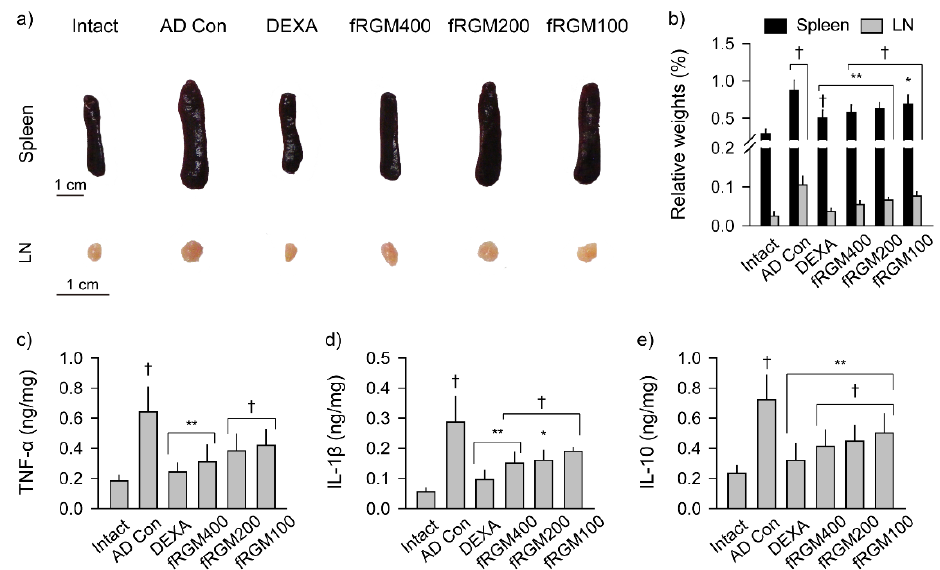
Figure 3. Effects on lymphoid organs and the production of inflammatory cytokines. ( a ) Representa- tive images of the spleen and lymph node (LN). ( b ) Relative weights of the spleen and LN to body weights. ( c – e ) Splenic levels of tumor necrosis factor (TNF)- α , interleukin (IL)-1 β , and IL-10. Values are represented as means ± SDs. †: p < 0.05 vs. the Intact group; **: p < 0.01 and *: p < 0.05 vs. Con. AD